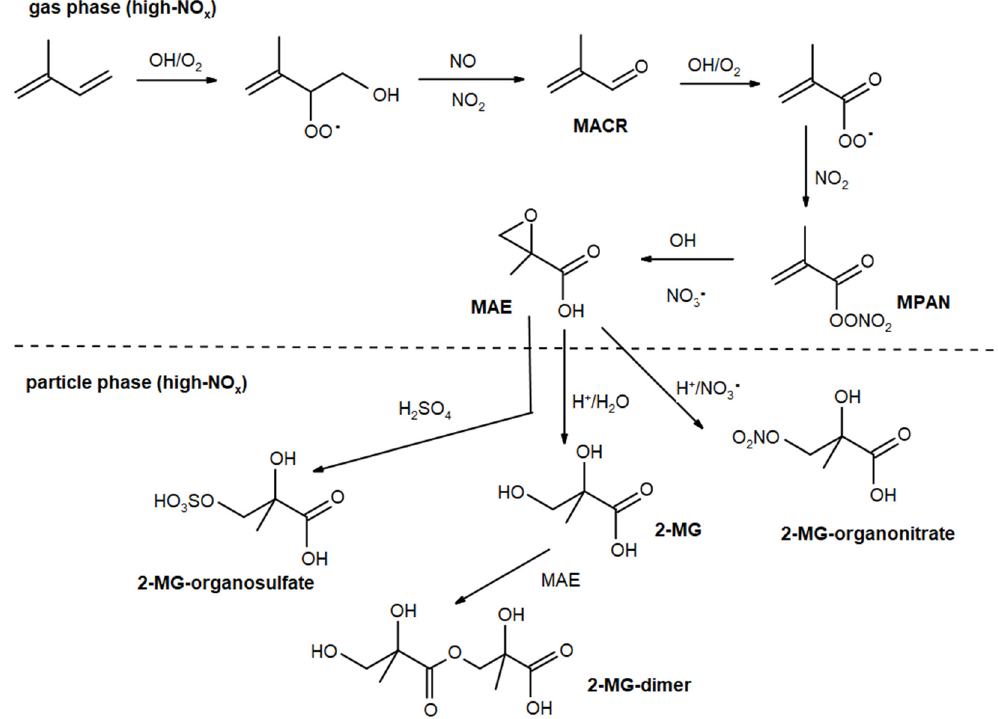
Figure 3. Formation pathway of isoprene SOA via methacrolein at high-NO x . Abbreviations: MACR: methacrolein; MAE: methacrylic acid epoxide; 2-MG: 2-methylglyceric acid; MPAN: methacryloylperoxynitrate (adapted from Lin et al., 2013 [8]).